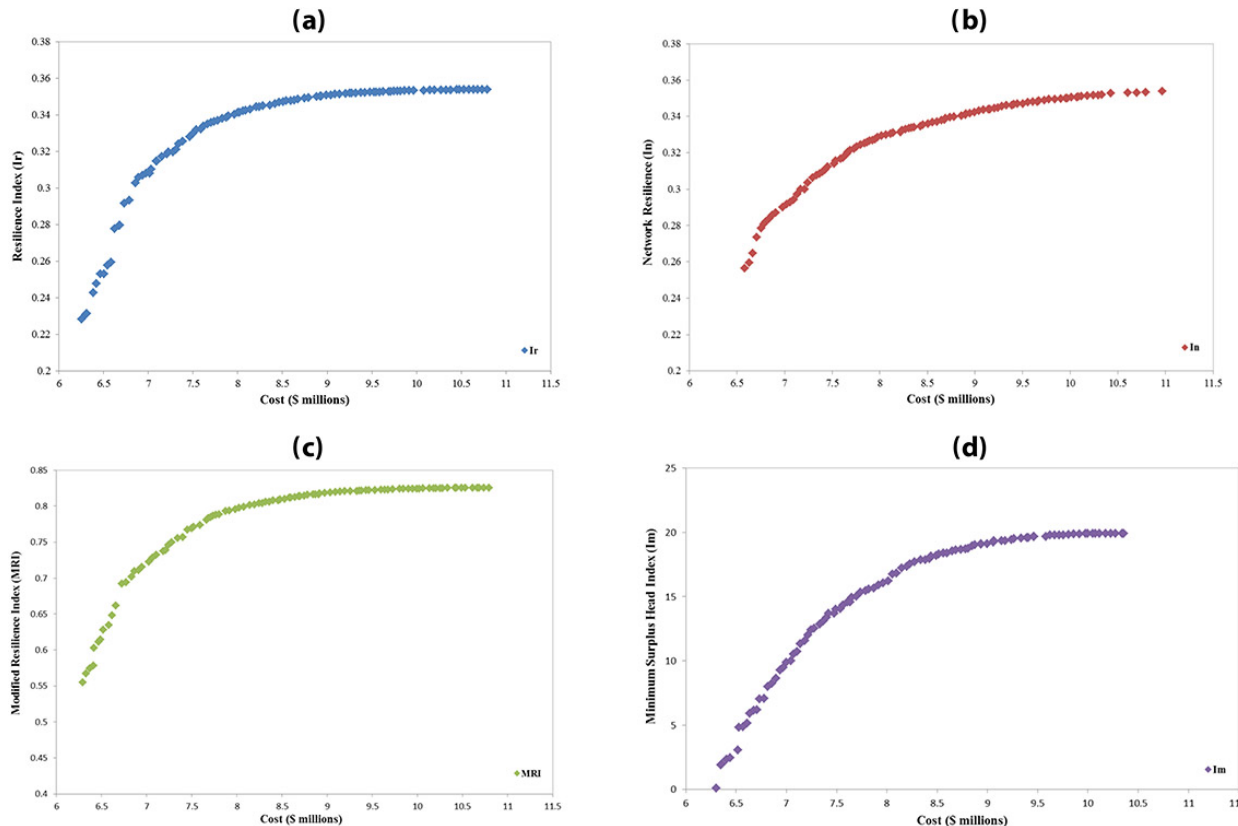
Figure 3. Pareto front of two-objective function optimization of the Hanoi network: (a) cost- I r , (b) cost- I n , (c) cost-MRI, and (d) cost- I m .